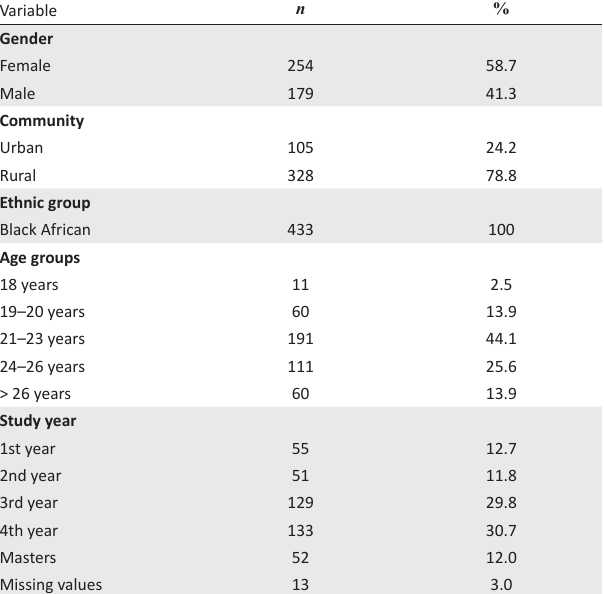
TABLE 1: Sociodemographic characteristics ( N =